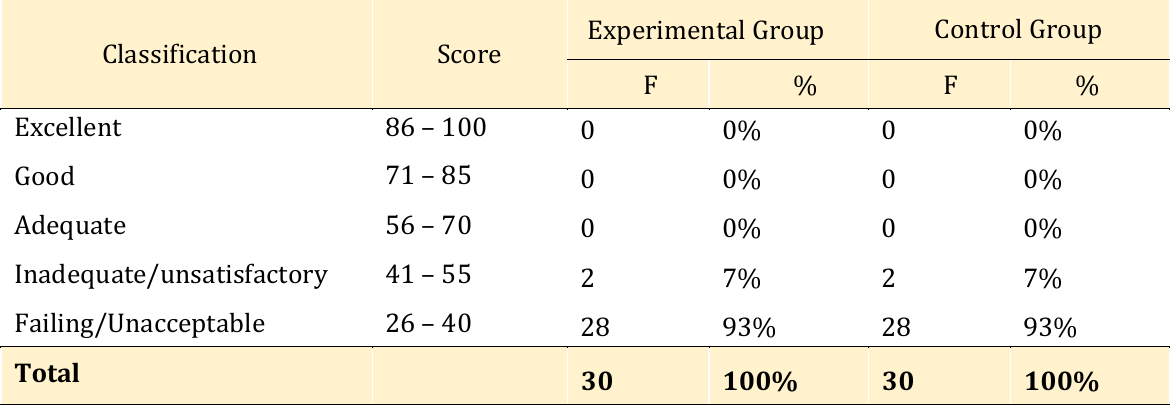
Table 1. The Frequency and Percentage of Students’ Achievement in term of Accuracy in Pretest